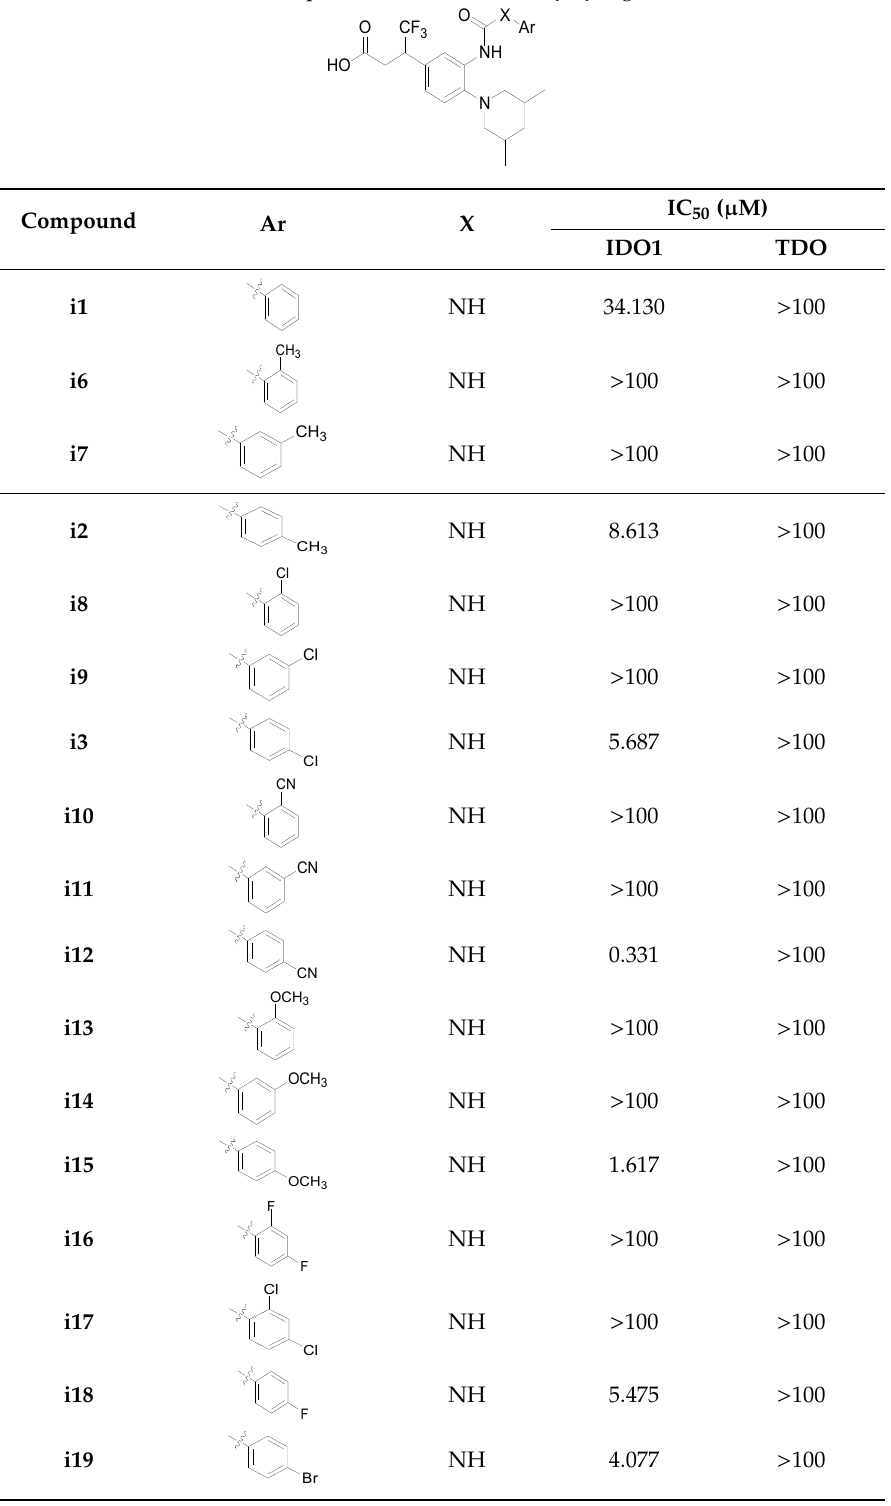
Table 2. IC 50 values of compounds i1–i3 , i6–i24 and j1–j3 against IDO1 and TDO.